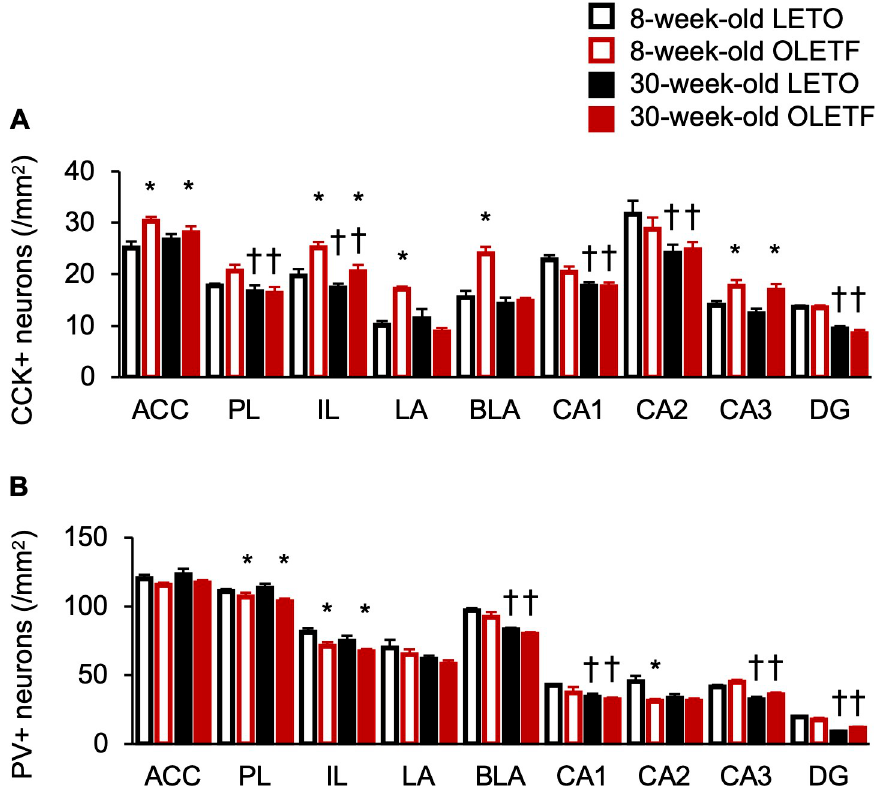
Fig 5. Densities of CCK- and PV-positive neurons in the corticolimbic regions. Densities of cholecystokinin- positive (CCK+; A ) and parvalbumin-positive (PV+; B ) neurons in the anterior cingulate cortex (ACC), prelimbic cortex (PL), infralimbic cortex (IL), lateral amygdala (LA), basolateral amygdala (BLA), hippocampal cornu ammonis (CA) area 1 (CA1), CA2, CA3, and dentate gyrus (DG). Values represent mean ± standard error of means. � Significant difference from age-matched LETO rats, p < 0.05; † significant difference from same strain at 8 weeks of age, p < 0.05, two-way ANOVA.